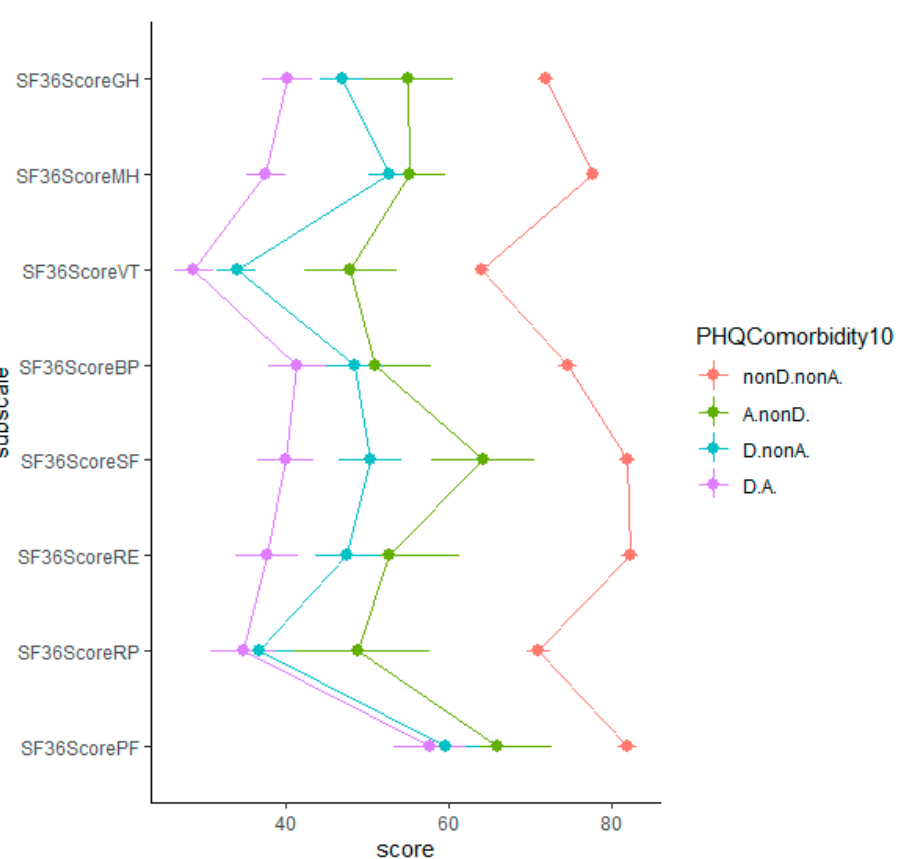
Figure A3. The relative impact of depression and anxiety on the physical and psychological outcomes with the cut-off point of 10 for PHQ-9 and GAD-7.